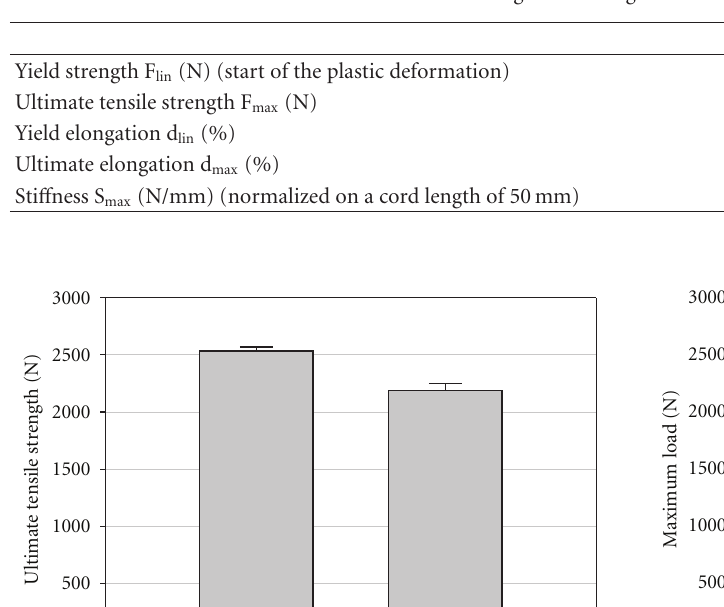
Table 2: Strength and elongation of fixed Trevira cords.